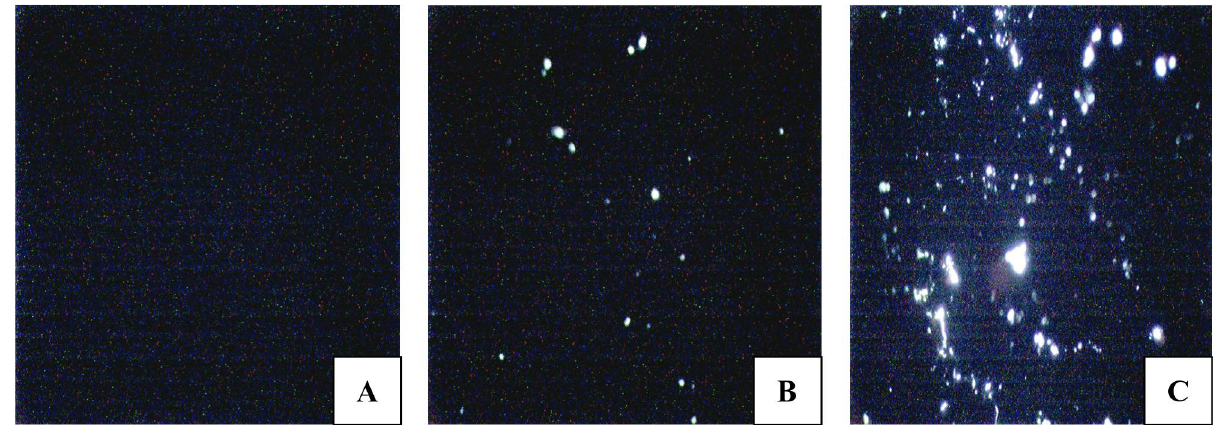
FIGURE 4. - Photomicrographs of aluminum foils in the in vitro skin protection test. A = MeA, B = MeB and C = Control.